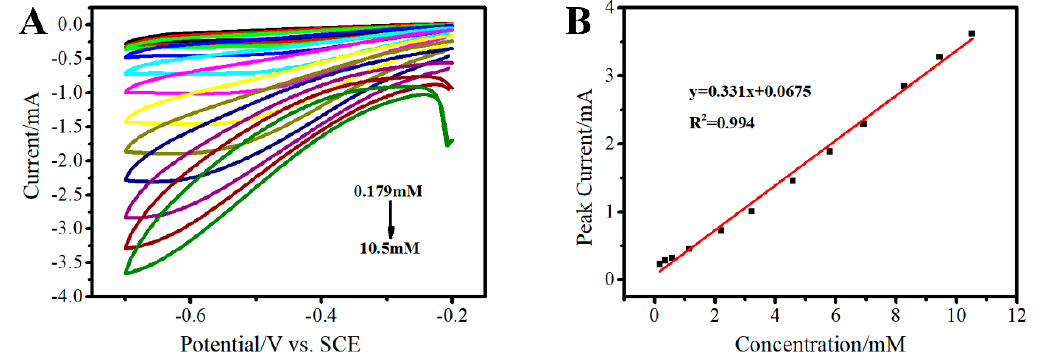
Figure 12. CVs of the 3D Au-rGO/FTO in PBS containing different concentrations of H 2 O 2 from 0.179 to 10.5 mM ( A ). The relationship between oxidation current versus the concentration of H 2 O 2 ( B ). Table 2. Comparison of different modified electrodes for H 2 O 2 determination.